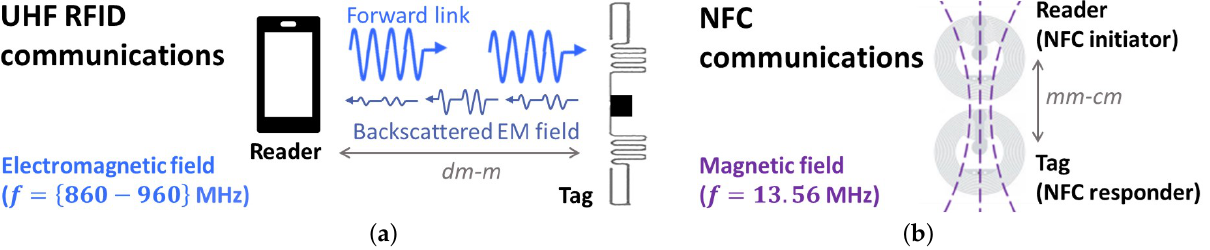
Figure 1. Scheme of the typical communications through RFID devices: electromagnetic links of ( a ) UHF RFID, with the operation frequencies considered in this work, and ( b )